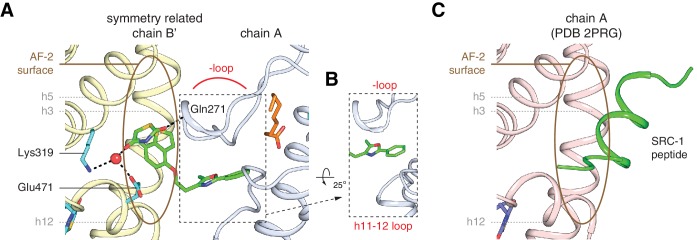
The TZD head group of the second edaglitazone molecule docks into the PPARγ AF-2 surface.(A,B) in a similar manner to a SRC-1 coactivator peptide bound to the AF-2 surface (C) in the crystal structure of rosiglitazone-bound PPARγ (PDB: 2PRG). The hydrophobic tail group of this second edaglitazone molecule packs within a surface pocket created by the Ω-loop and the loop connecting helix 11 and 12 (B). The second EDA ligand bridges interactions between two PPARγ molecules in different unit cells within the crystal lattice by binding to the Ω-loop region in one molecule (e.g., chain A) and the AF-2 surface of a symmetry related molecule (e.g., chain B’).